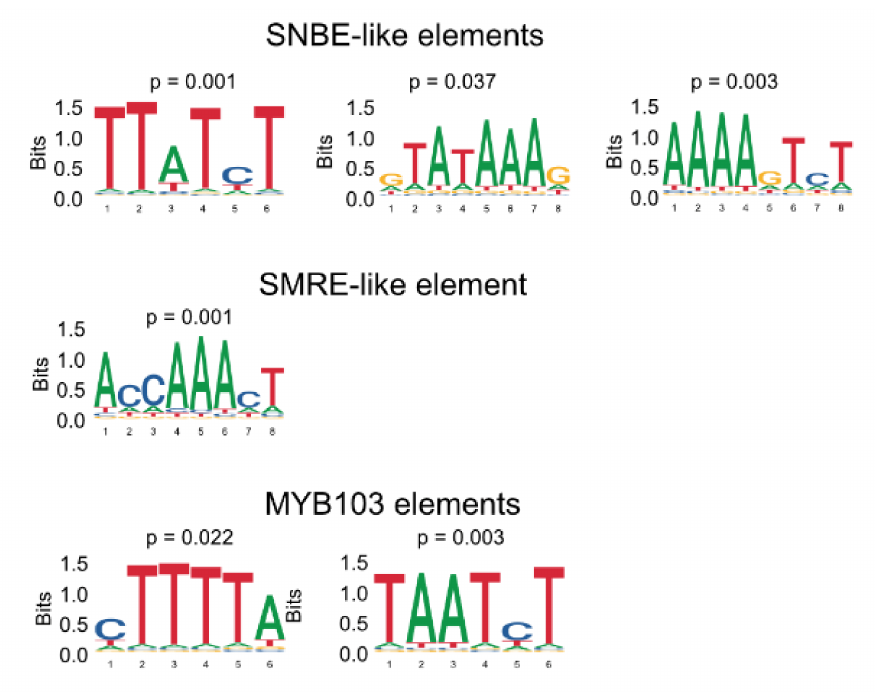
Figure 6. Motifs discovered and overrepresented in genes induced by expression of SND1 and